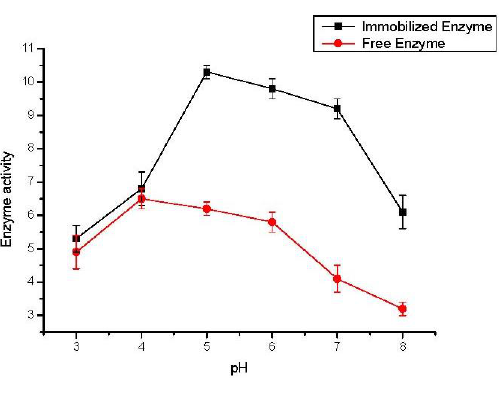
Figure 1. Effect of buffer pH on the activity (μmol/g·h) of free and immobilized TVL. Reaction conditions: trans-resveratrol 2 mmol, n -butanol 40 mL, Na2HPO4–sodium citrate buffer 10 mL (pH 3–8), immobilized TVL laccase (enzyme content: 5 mg), reaction temperature: 45